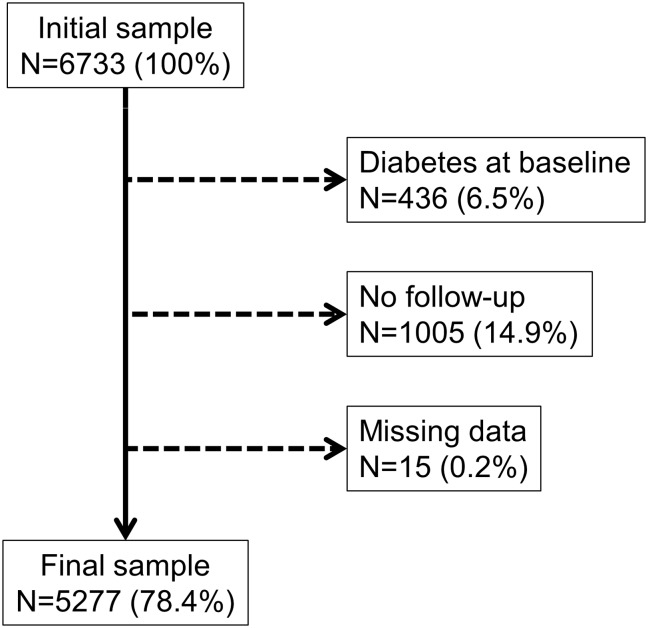
Flowchart of the participants of the CoLaus/PsyCoLaus study.